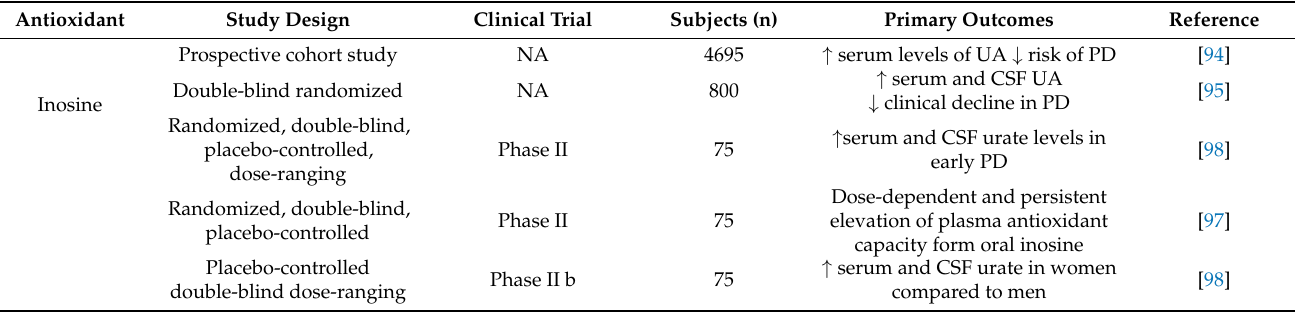
Table 2. Summary of inosine antioxidant effect on PD clinical